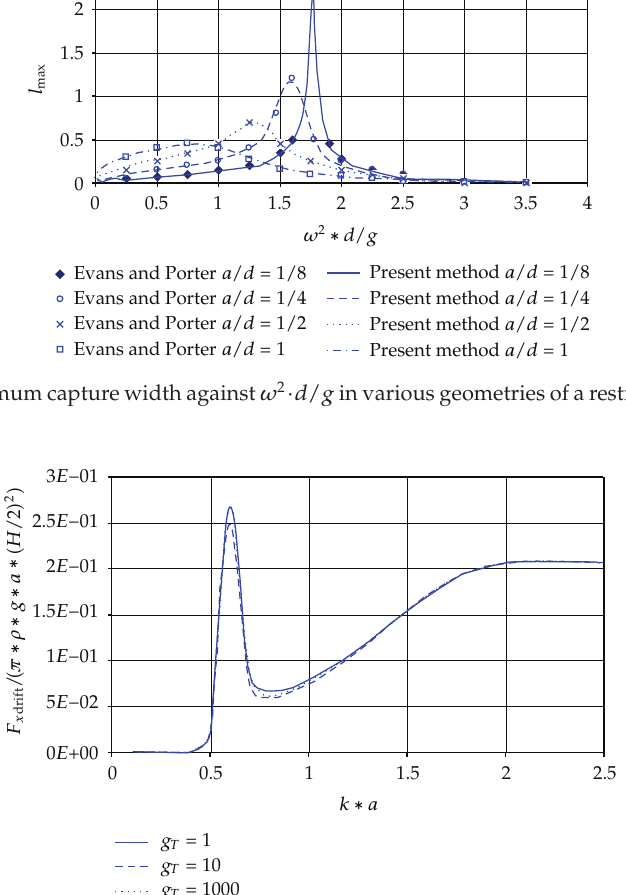
and outer radius are b (cid:8) 2 m, a (cid:8) 20 m, respectively, and the water depth is d (cid:8) 20 m.